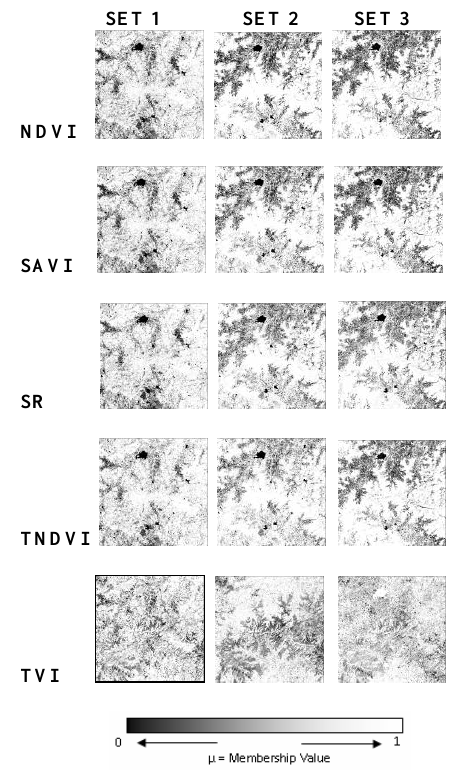
Figure 4:Output showing cotton crop using Noise